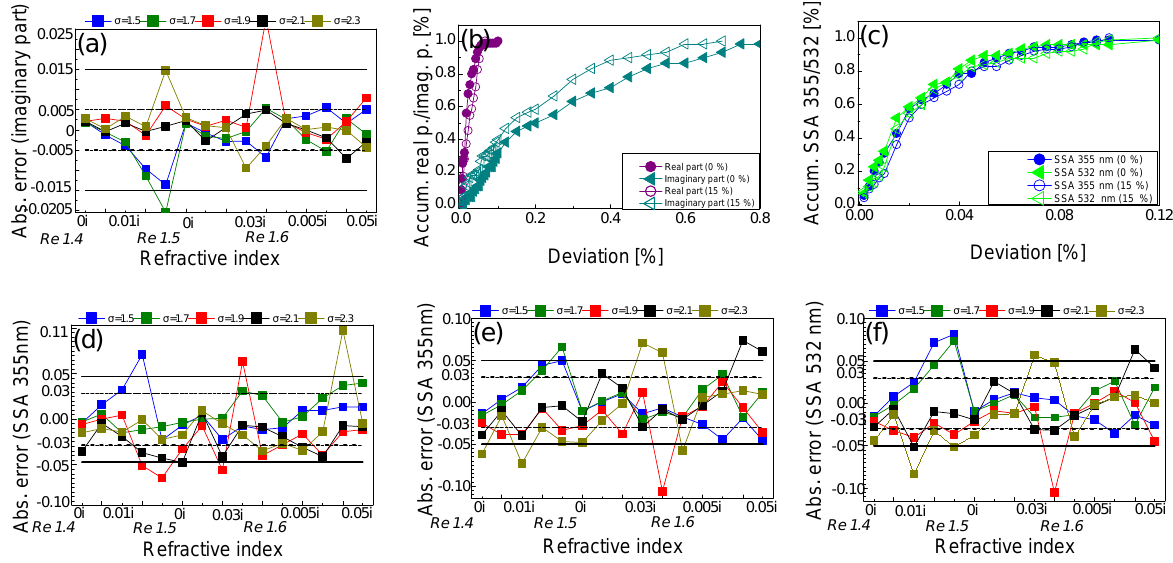
Figure 8. Accumulative distribution of inversion results for UP algorithm (b, c) . In the case of (b) complex refractive index and (c) single scattering albedo we show the accumulative sum (1.0 means 100%) in dependence of the deviation in percent from the true result. Cases (a) and (d) – (f) show absolute errors of the retrieval results: (a) imaginary part of CRI for 15% noisy input data, (d) SSA 355nm (noiseless), (e) SSA 355nm (15% noisy input data) and (f) SSA 532nm (15% noisy input data). Each subfigure (a) , (d) – (f) is compartmentalized into three partition with respect to the horizontal axis (refractive index). The partitions correspond to different real parts of CRI namely 1.4, 1.5, and 1.6. Each partition shows the result for different imaginary parts of the CRI: 0, 0.005, 0.01, 0.03, 0.05 i .